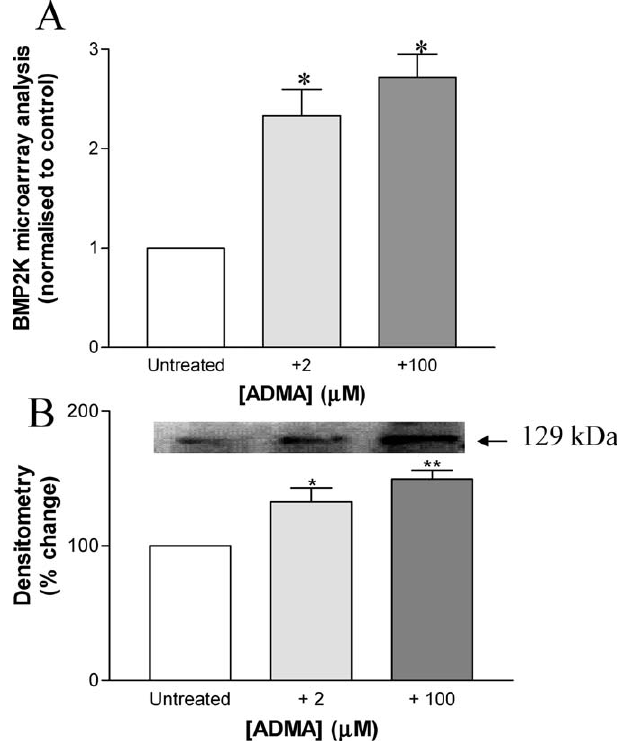
Figure 5. ADMA Alters BMP2K Gene Expression and Protein Levels (A) BMP2K is increased more than 2-fold in HCAEC following 24-h ADMA treatment (2 l M and 100 l M ADMA increased expression by 2.304-fold [ p ¼ 0.00128] and 2.695-fold [ p , 0.001] respectively). (B) BMP2K protein levels are increased in HCAEC following 24-h treatment with ADMA (2 and 100 l M) as determined by Western blotting, using a commercially available BMP2K antibody (Orbigen). Densitometry of the BMP2K band was carried for each of the blots from four separate experiments (untreated versus 2 l M: p , 0.05; and untreated versus 100 l M: p , 0.01, n ¼ 4). The inset blot is representative of four separate experiments, where equal amounts of protein were loaded in each lane. DOI: